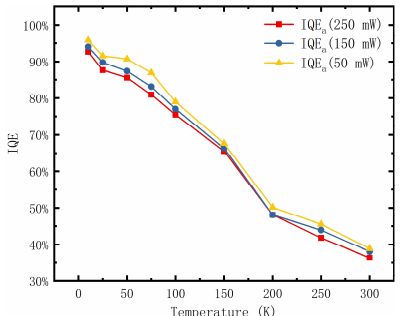
Figure 6. The modified internal quantum efficiency (IQE) values at different temperature and three fixed excitation power which are in line with power dependent photoluminescence (PDPL) results at room temperature (RT).